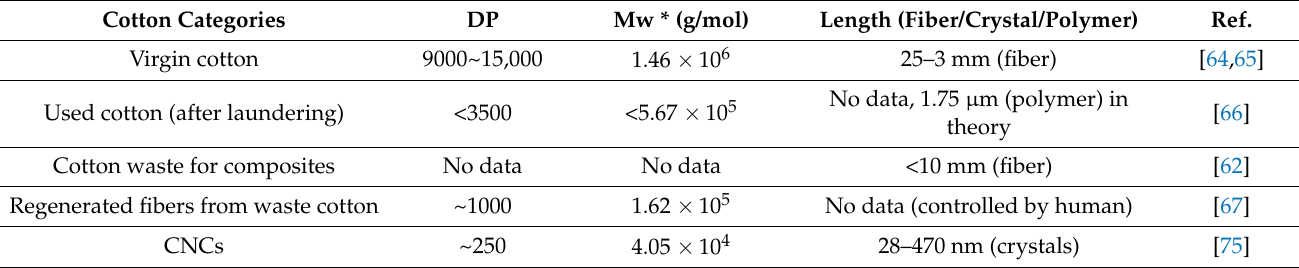
Table 2. Summarized size attributes of cotton used in different recycling